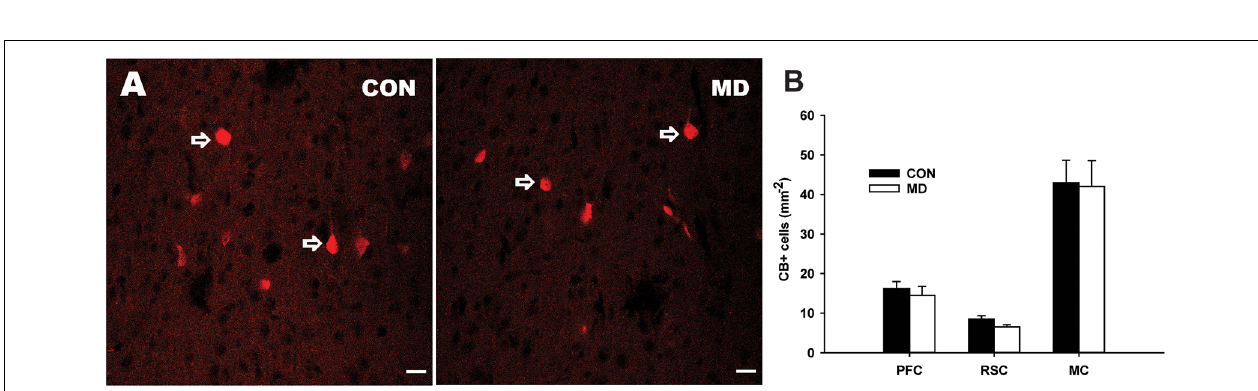
FIGURE 2 | Calbindin-expressing neurons. (A) Representative images of immunofluorescence staining for calbindin in the prefrontal cortex of a control (CON, left panel) and MD (right panel) rat at P60. (B) Shown are mean values + standard error of the mean (SEM) for profile densities (number of immunopositive cells per area) of calbindin+ neurons in the neocortex of MD and CON rats ( p > 0.05, t -test, n = 6 animals per group). Scale bars: 20 µ